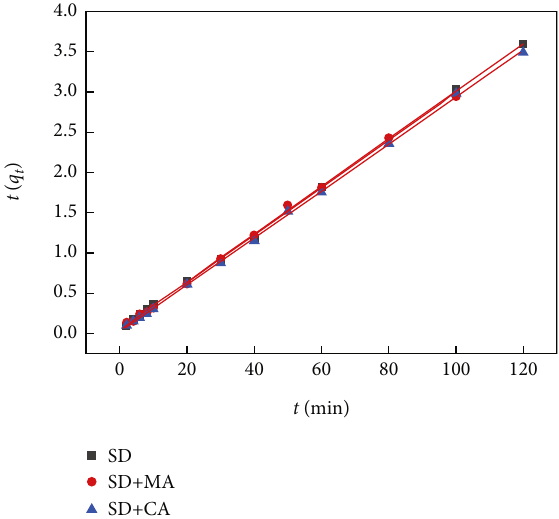
Figure 11: The pseudo- fi rst-order kinetic model fi tting of adsorption kinetics curves of SD, SD+MA, and SD+ CA. Figure 12: The pseudo-second-order kinetic model fi tting of adsorption kinetics curves of SD, SD +MA, and SD